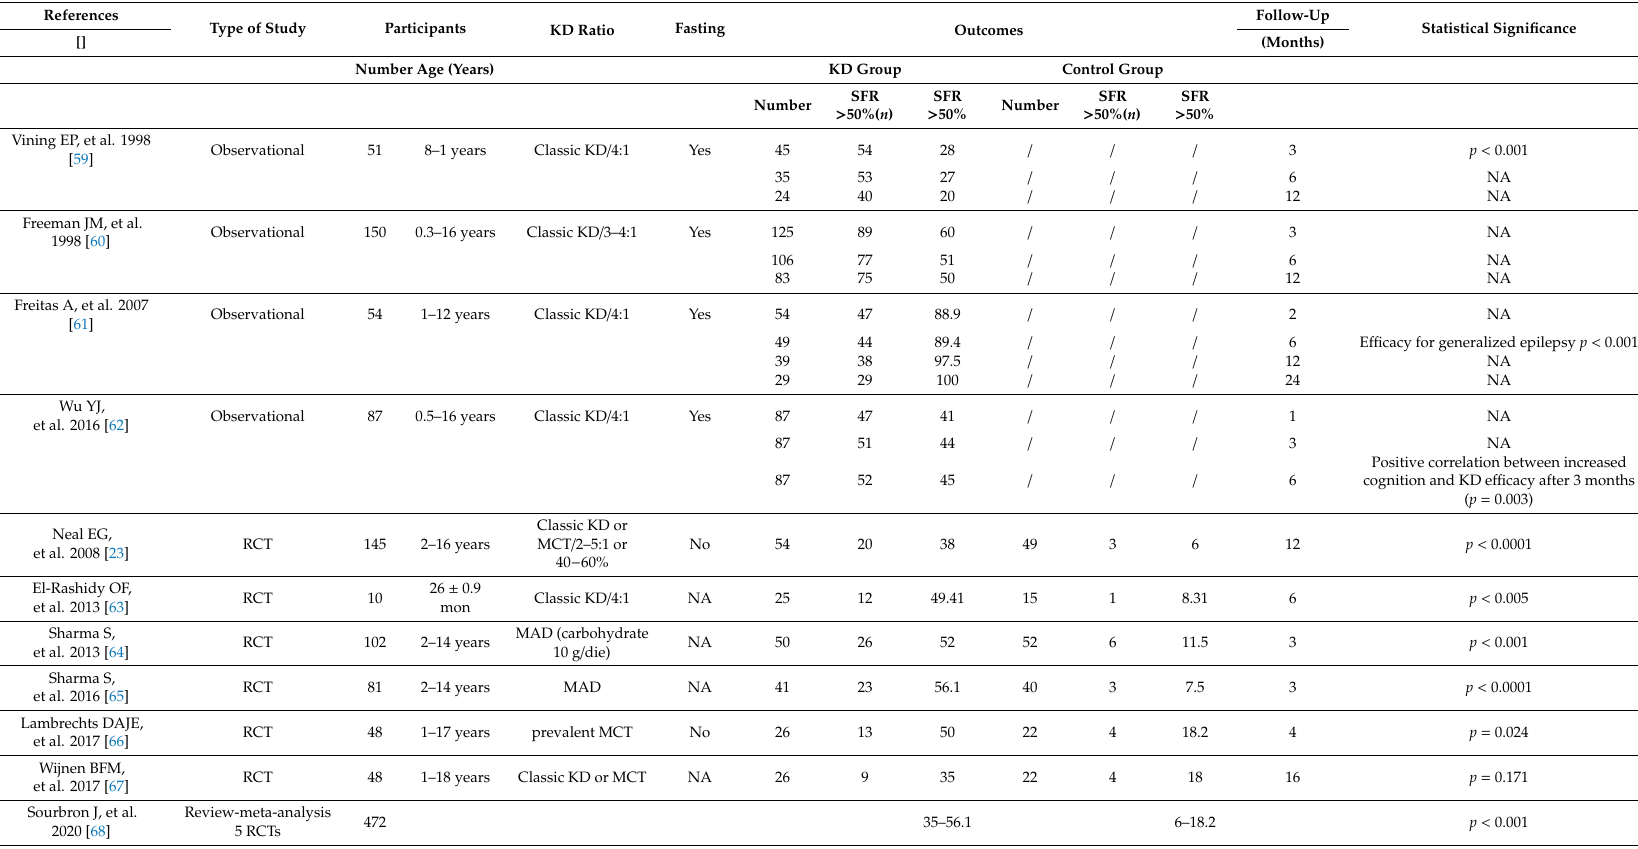
Table 3. Most relevant articles on the use of KD (associated with AED therapy) in pediatric refractory